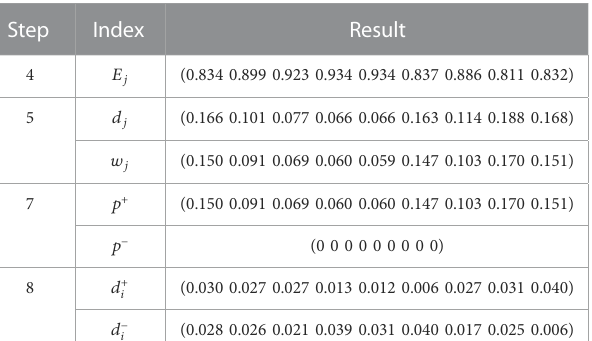
TABLE 7 Subjective comfort evaluation